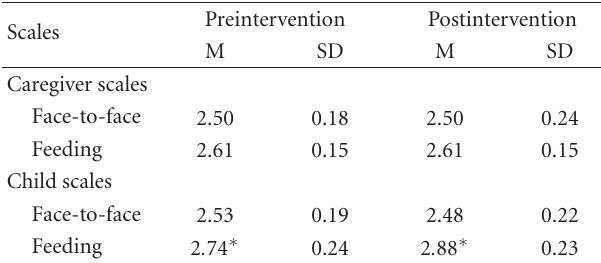
Table 4: Interaction rating scale by study